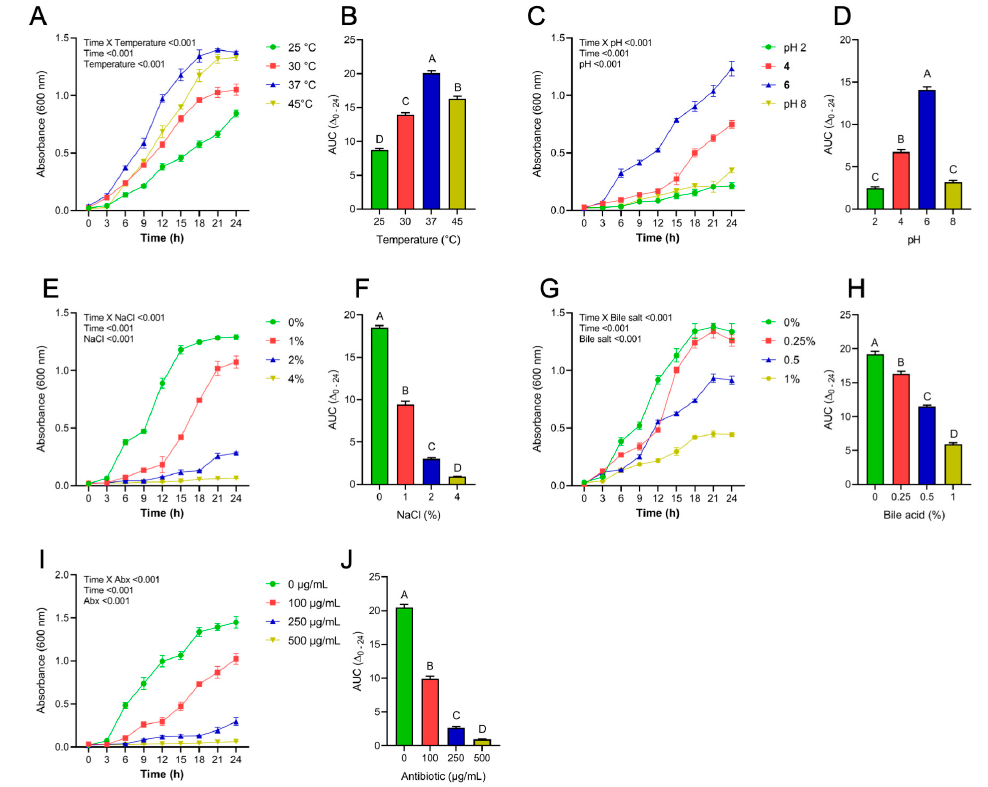
Figure 1. Growth curves and corresponding area under the curve (AUC) of L. plantarum grown under different stress conditions. The stress conditions include ( A , B ) temperature; ( C , D ) pH; ( E , F ) sodium chloride; ( G , H ) bile salt; and ( I , J ) antibiotic ampicillin. Data represented as mean ± SEM of 3 measurements. Data analysis was performed by 2-way repeated measure ANOVA to evaluate the effects of individual variables and their interaction with time. Tukey’s post hoc test was used to calculate the differences in AUC 0 – 24h for each treatment. Groups not sharing a common letter are significantly different ( p ≤ 0.05).